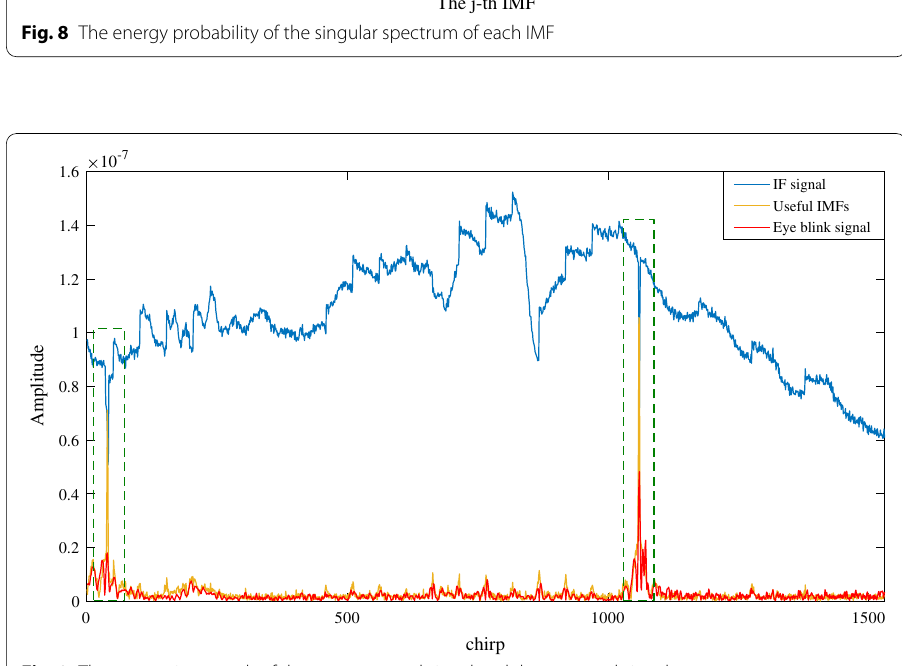
Fig. 9 The comparison result of the reconstructed signal and the averaged